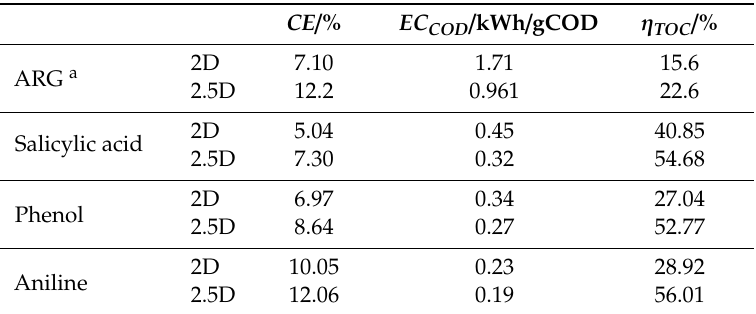
Table 1. The parameters comparison of 2.5D and 2D electrode. CE / % EC COD / kWh / gCOD η TOC /